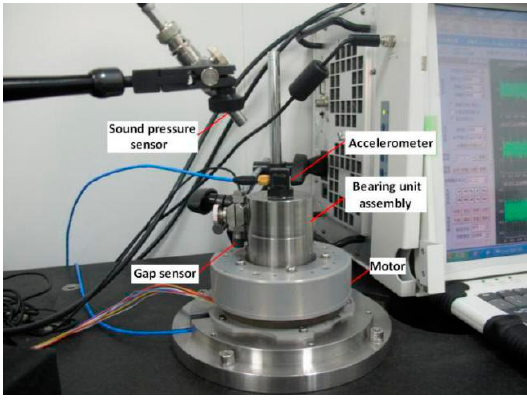
Figure 1. The experimental device.